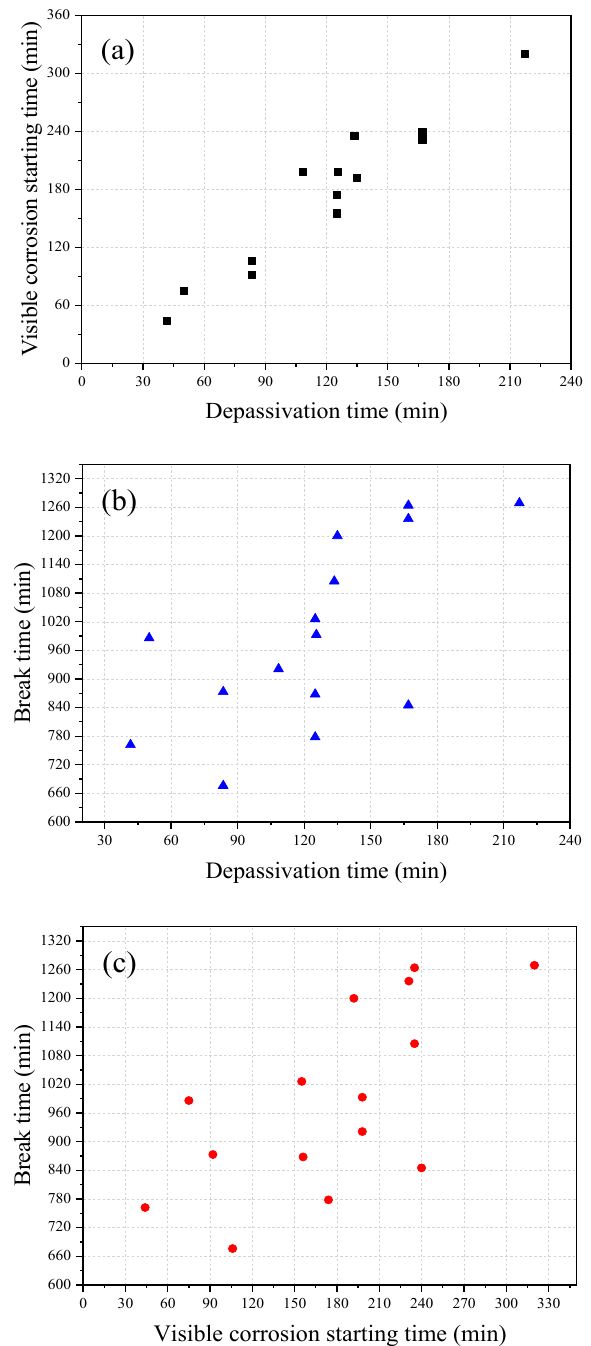
Figure 7. Correlation between ( a ) passivation breakdown time and visible corrosion starting time (correlation coefficient of 0.96), ( b ) between steel wire break time and passivation breakdown time (correlation coefficient of 0.66), ( c ) between steel wire break time and visible corrosion starting time (correlation coefficient of 0.67) obtained from 15 corrosion tests.